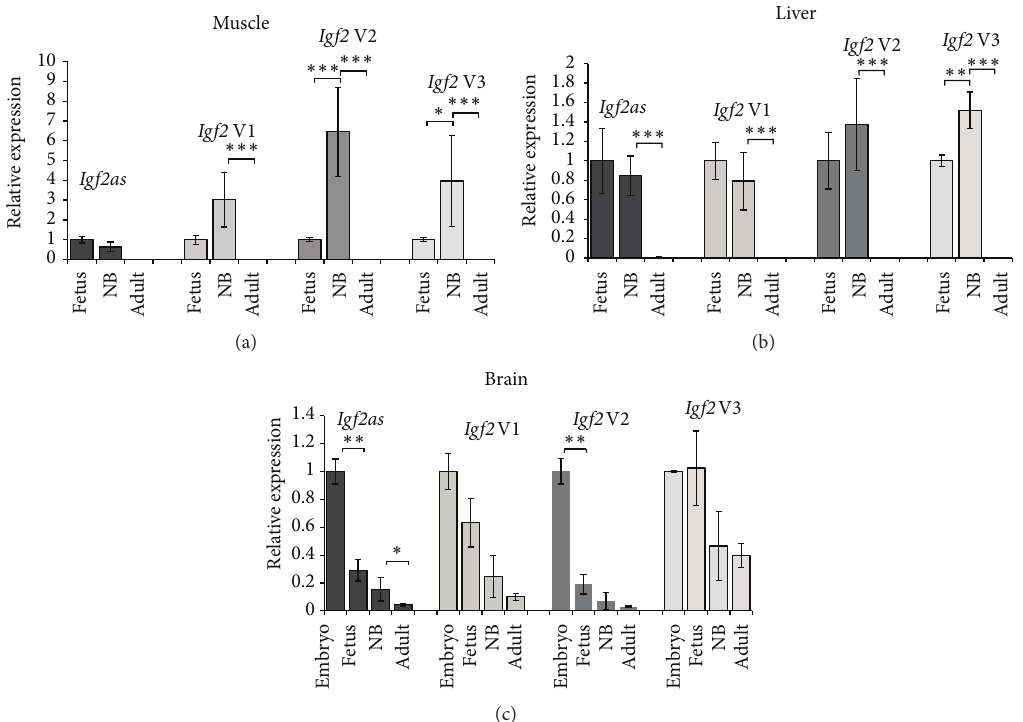
Figure 2: Quantification of expression levels of Igf2 variants and Igf2as transcripts in different tissues. Igf2 variants and Igf2as were quantified in muscle (a), liver (b), and brain (c) tissues of fetus, newborn (NB), and adult and included embryonic brain. V1, V2, V3, and Igf2as stand for Igf2 variants 1, 2, 3, and Igf2 antisense, respectively. The results are expressed in relative expression, calculated relative to the first value. Each bar represents the mean of three samples each analyzed in triplicate. The standard deviations are indicated as error bars. ∗ 𝑃 < 0.05 , ∗∗ 𝑃 < 0.01 , and ∗∗∗ 𝑃 < 0.001 .